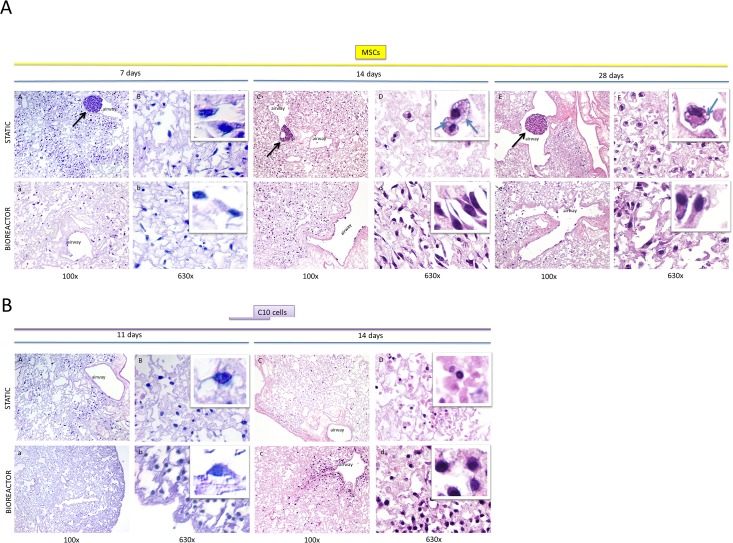
Hematoxylin-eosin staining of decellularized lungs recellularized with (A) MSCs in static (panels A to F) and bioreactor (panels a to f) conditions for 7, 14, and 28 days, and (B) with C10 cells in static (panels A to D) or bioreactor (panels a to d) conditions for 11 and 14 days.For each condition, a low (100x) and high magnification (630x) are shown (e.g., A is low magnification, B is high magnification). Insets are included to show phenotypes at the single cell level. Black arrows point to MSC cell aggregation observed in static recellularization conditions. Blue arrows point to cytoplasmic vacuoles indicative of cell stress. Airways are labelled. For each condition, images are representative of the entire lung, with the exception of panels AA and AB, which reflect a region with high cell density whereas some regions were devoid of cells (not shown).